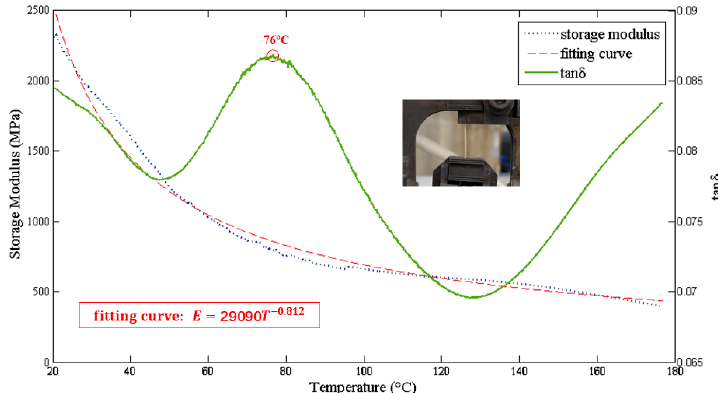
Figure 3. Storage modulus (dot line), fitting curve (dash line), and tan δ (solid line). tan δ is the ratio of loss modulus (not shown in this figure) to storage modulus whose first maximum point can be used to locate the glass transition temperature.